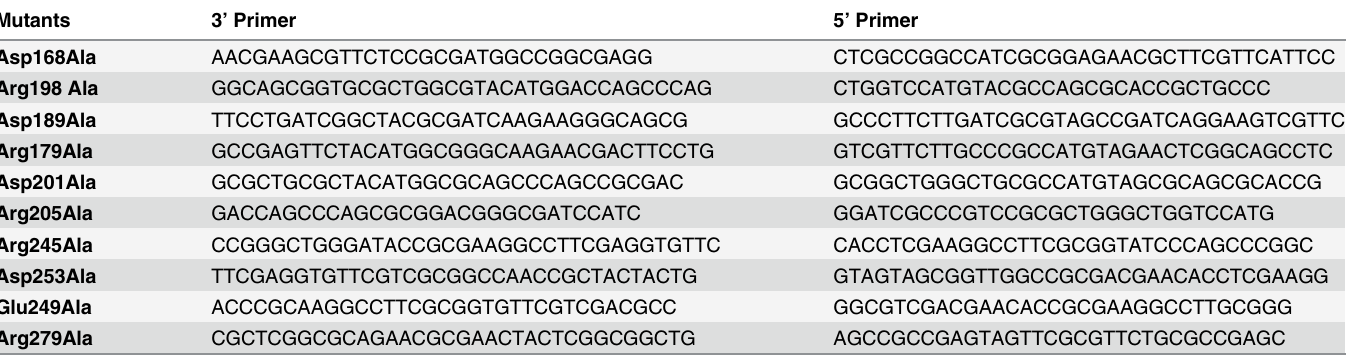
Table 1. Primers used for site-directed